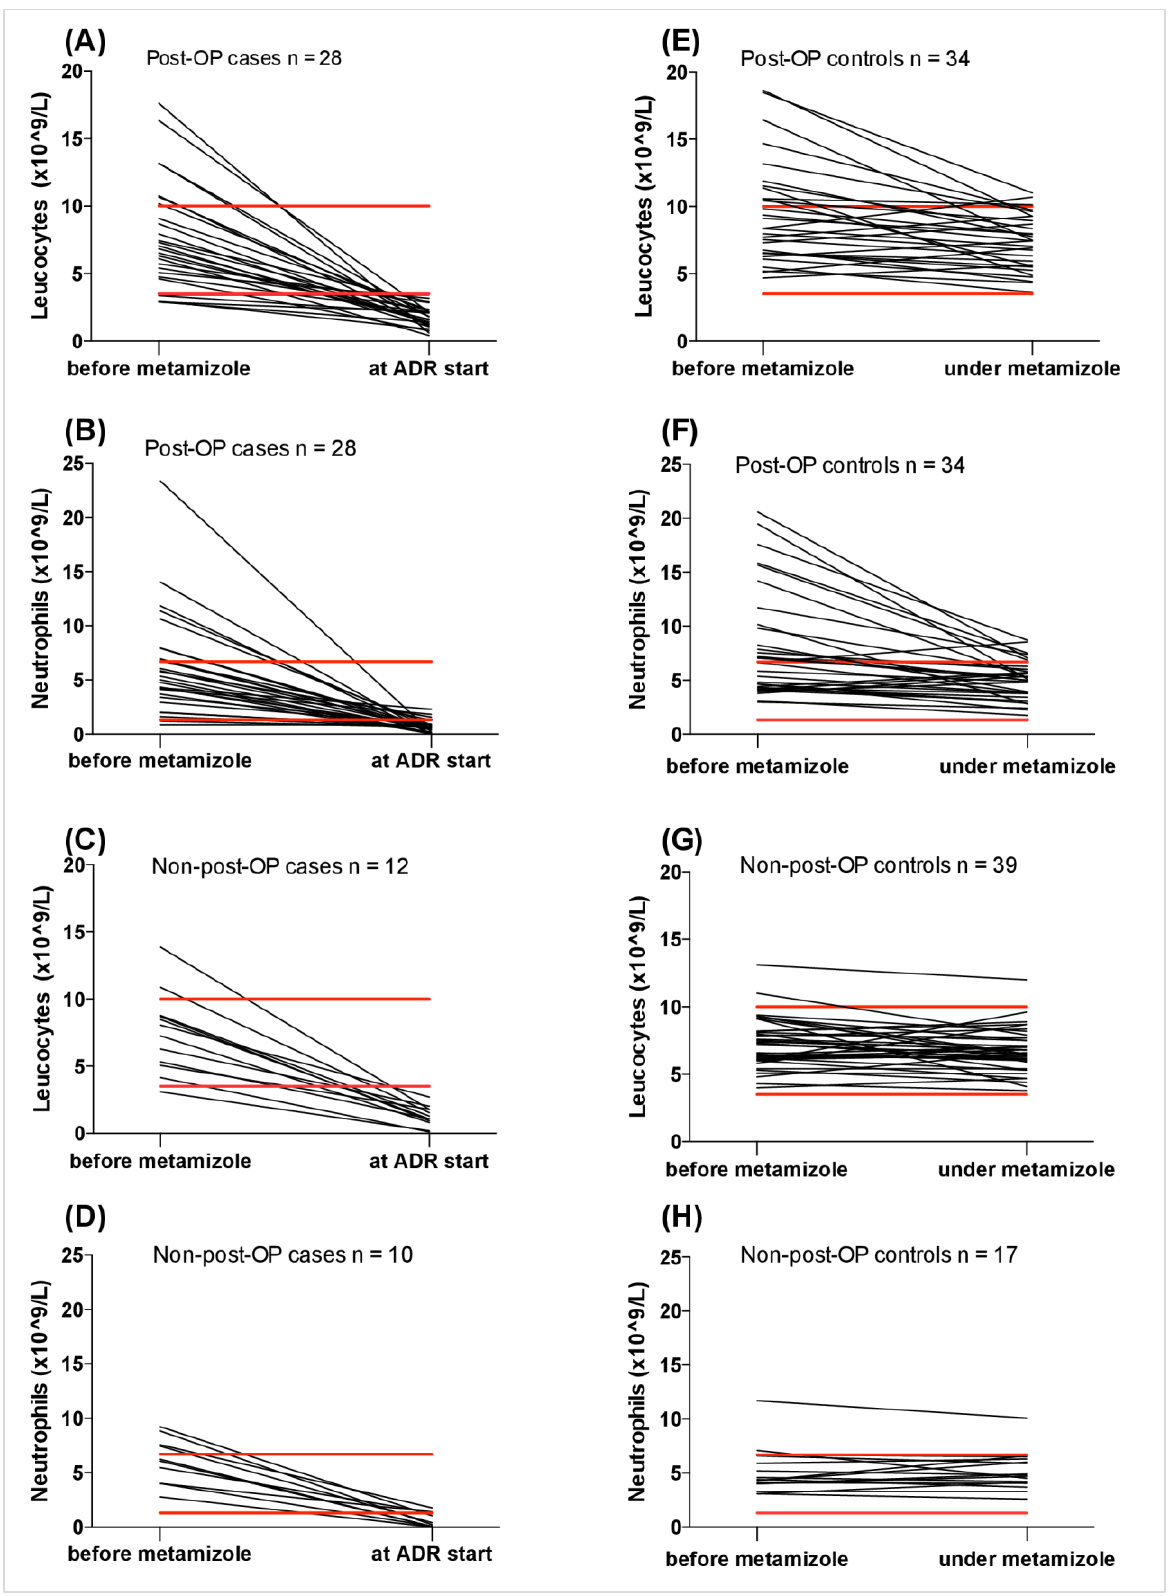
Figure 1: Leucocyte and neutrophil counts before starting metamizole and at time of diagnosis of ADR (case groups A–D) or at last follow-up while taking metamizole (control groups E–H). Red lines indicate upper and lower reference values (10–3.5 × 10 9 /l for leucocytes and 6.7–1.3 × 10 9 /l for neutrophils). ADR = adverse drug reaction; post-OP =